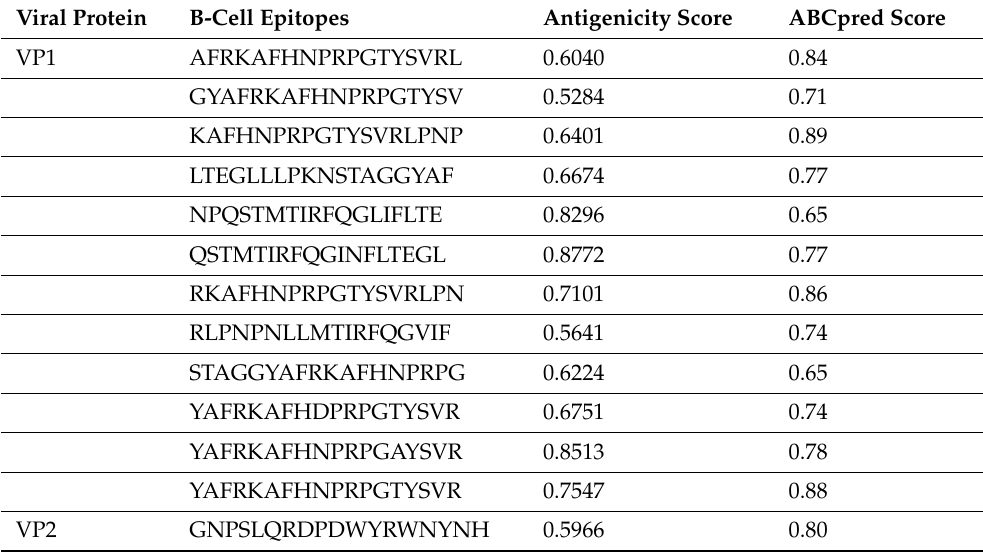
Table 3. Predicted linear B-cell epitopes showing their antigenicity. Viral